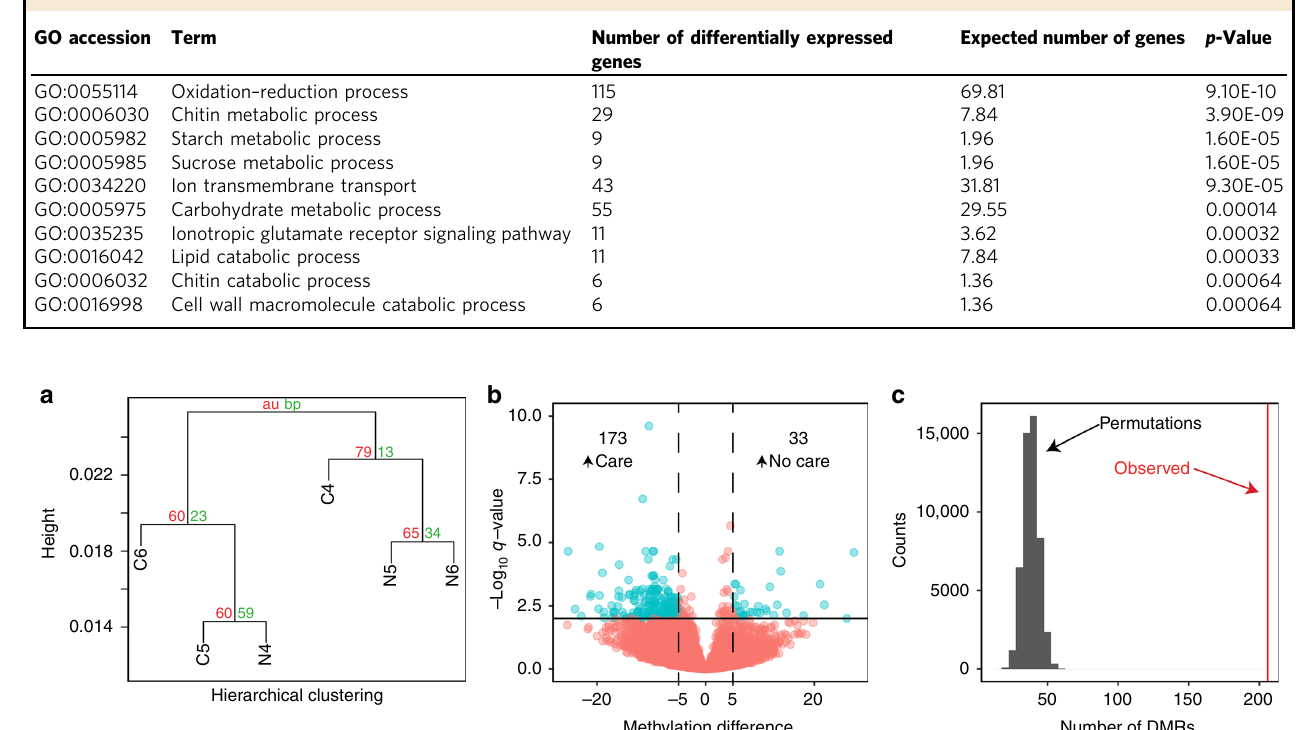
Table 1 Gene Ontology (GO) biological process term enrichment among genes differentially expressed between “ care ” and “ no care ” offspring (Fisher ’ s exact test p -value <0.001)